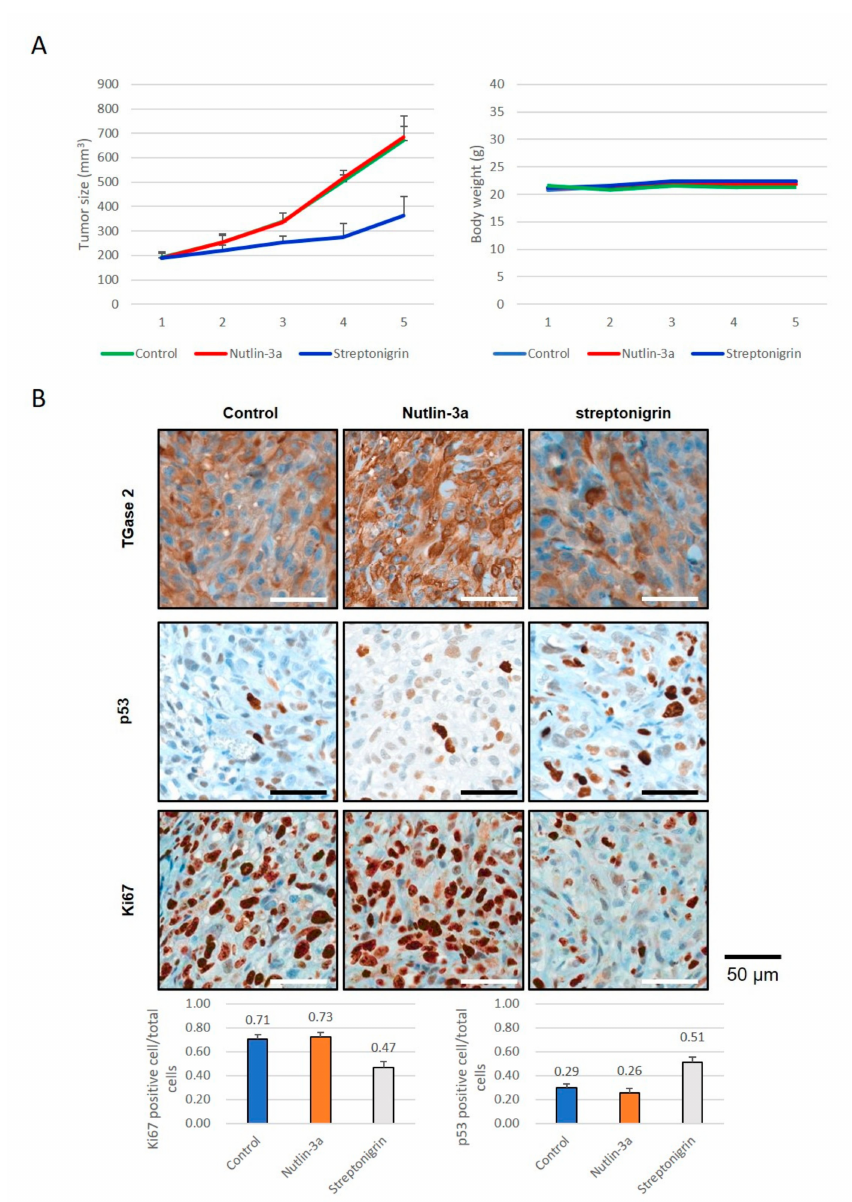
Figure 4. The anticancer e ff ects of inhibition of TGase 2 and MDM2 in a human RCC xenograft model: ( A ) ACHN cells were injected subcutaneously into one flank of BALB / c nude mice ( n = 5). Mice received streptonigrin or nutlin-3a when tumors reached a volume of 200 mm 3 . The average tumor volume and body weight is presented as the mean ± SE. ( B ) ACHN cells harvested from BALB / c nude mice were analyzed by immunohistochemical staining for Ki67, TGase 2, and p53. The bar graph represents the percentage of cells positive for Ki67 or p53. Cumulative data from three independent experiments are shown (mean ± SD; n = 3). ** p < 0.01 and *** p <